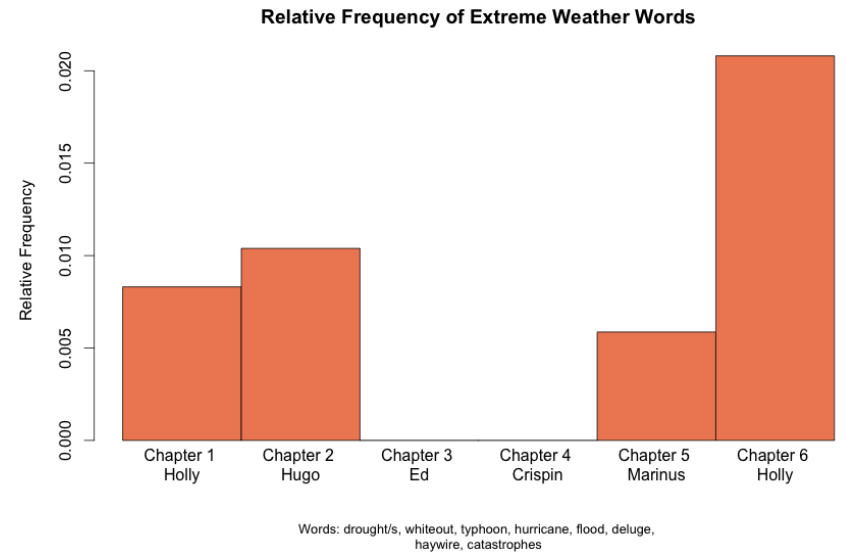
Figure 3. The relative frequency of extreme weather words in the text. Extreme weather features in the first two chapters, then is absent from the middle of the book, has a slight presence in the penultimate chapter, and comes back aggressively in the sixth and final chapter, which reveals that weather is what we should have been paying attention to throughout.